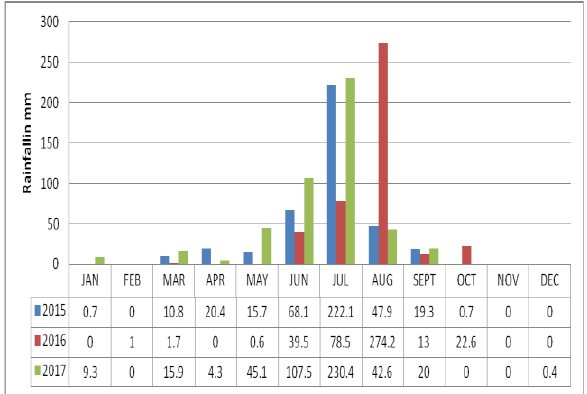
Fig. 4. Rainfall variability in Jodhpur district from 2015 to 2017 ( Source: IMD, Delhi).